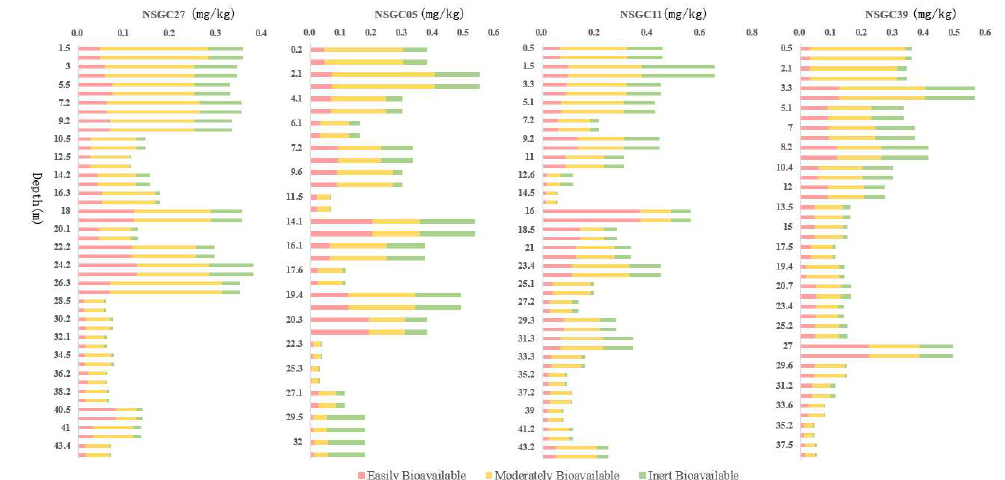
Figure 10. Bioavailability of Cd in each core.